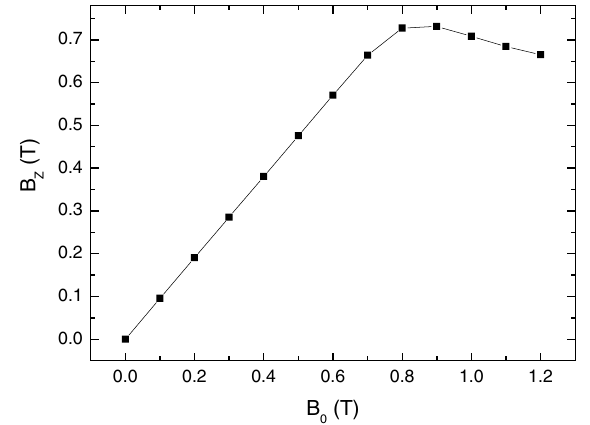
FIG. 3. Maximum vertical field strength B the longitudinal field B ducting solenoid